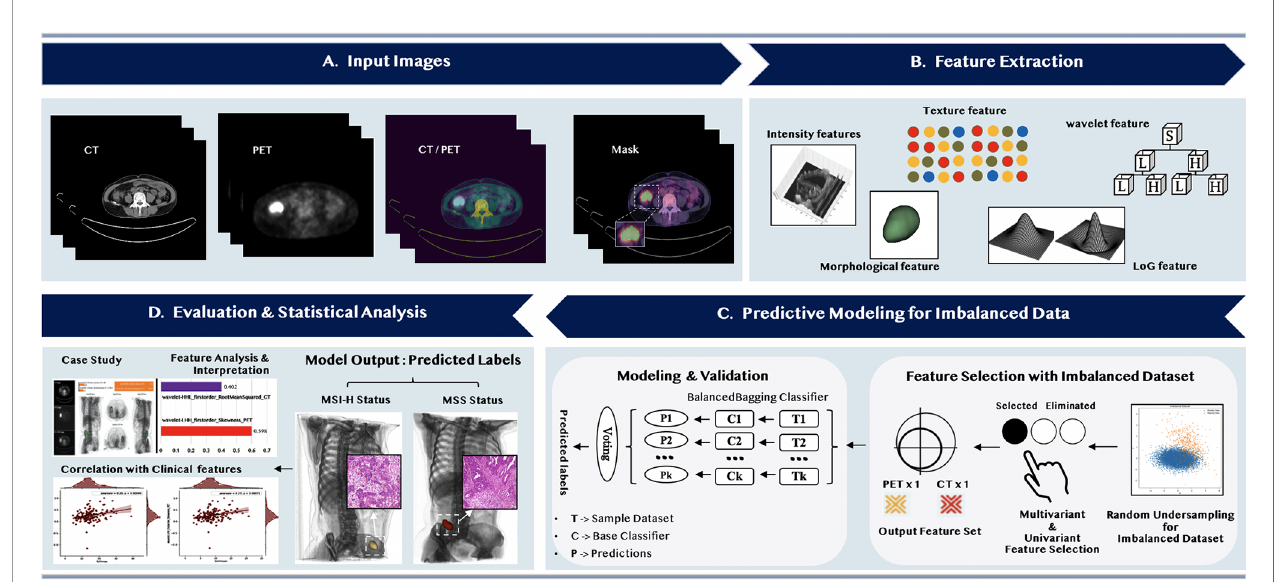
FIGURE 1 | The overall fl owchart of predicting the microsatellite instability status of the colorectal cancer